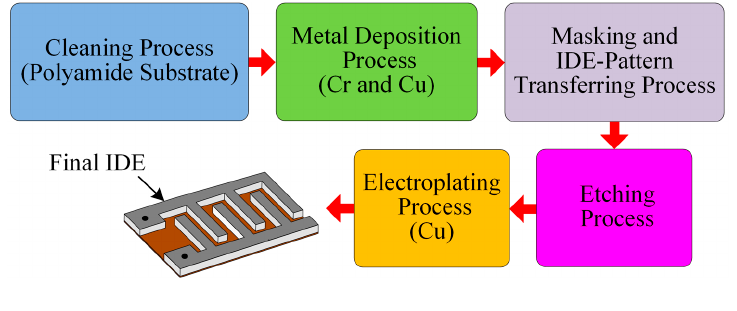
Figure 3. Fabrication stages of the IDE.